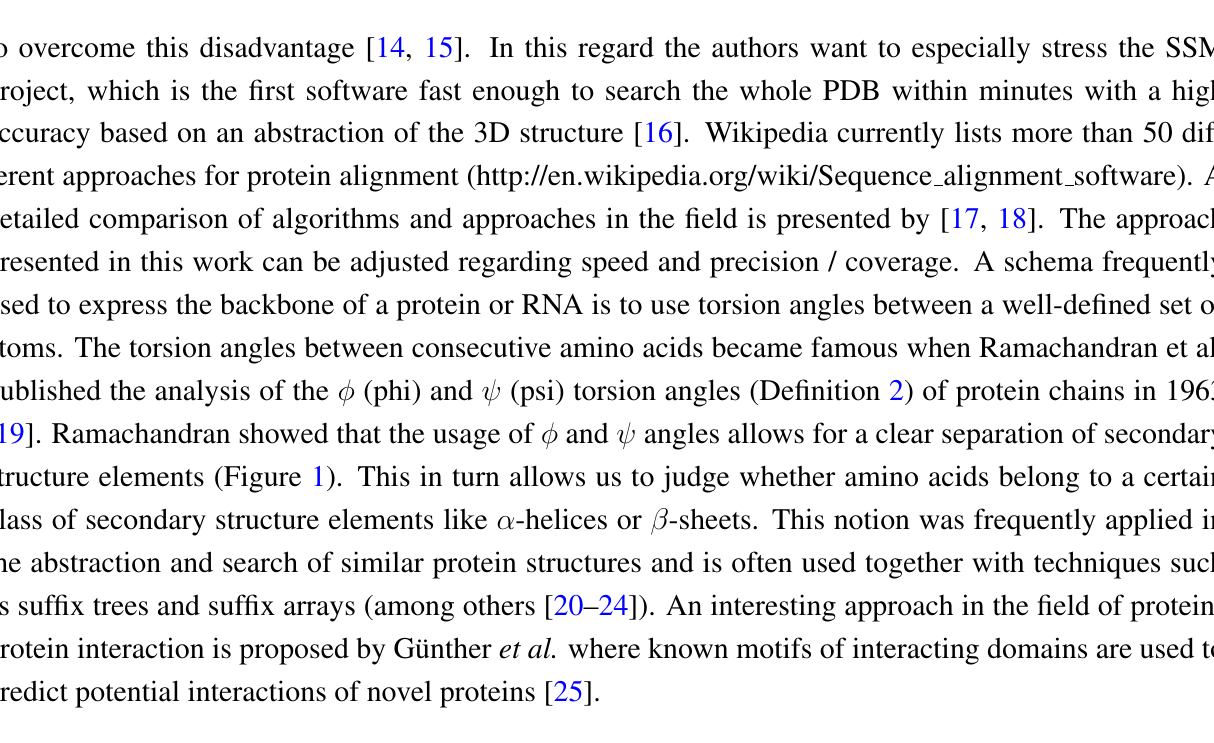
Figure 1. The Ramachandran ( φ - ψ torsion angle) plot of a Thymidylate Synthase (PDB-ID: 1AXW). The cluster in the upper left corresponds to β -sheets, the cluster in the middle left corresponds to α -helices, and the small cluster in the middle right represents left handed helices. The main clusters (B,H,L) are used to translate a protein structure into a